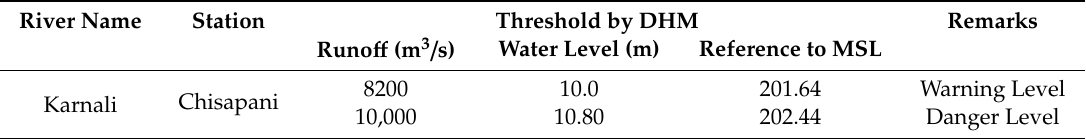
Table 3. Classification of threshold discharge (m 3 / s), water level gauge height (m) and mean above sea level (a.s.l.) reference height categorized according to the warning and danger levels for flood forecasting in Karnali used by the DHM, Nepal